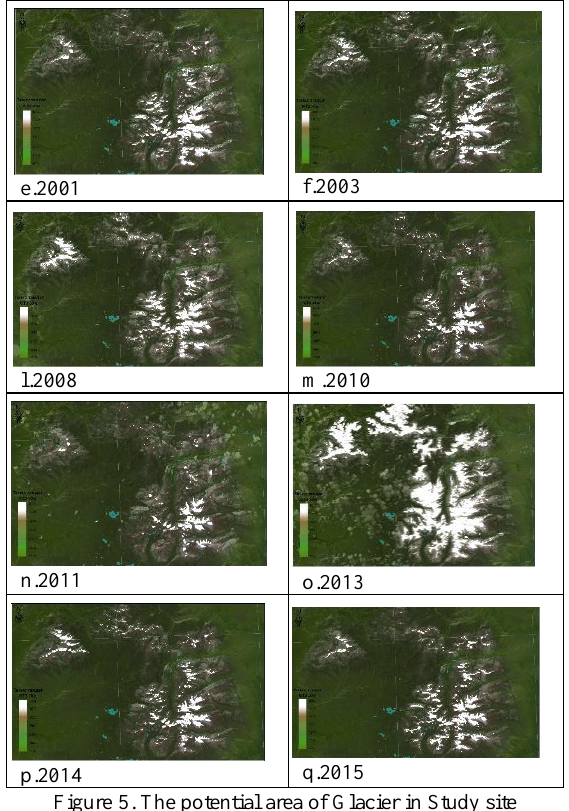
Figure 5. The potential area of Glacier in Study site